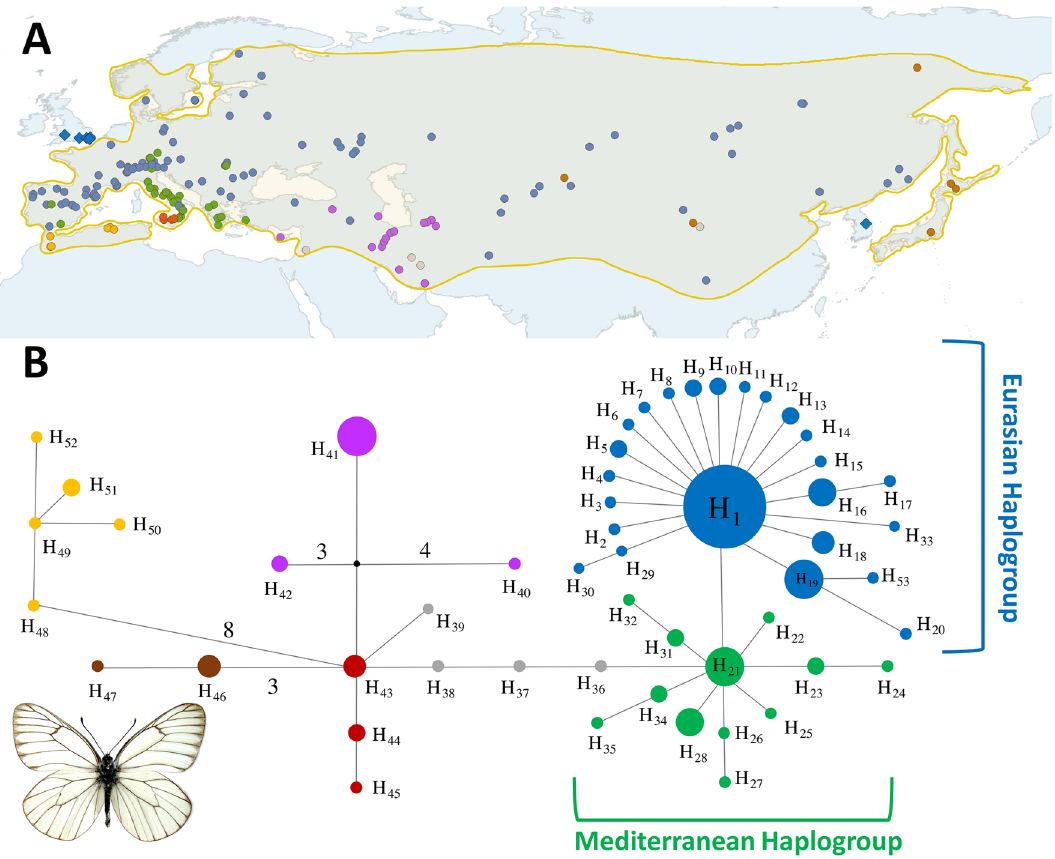
Figure 2. ( A ) Sampling localities and approximate geographic distribution areas of the Aporia crataegi redrawn after 9,23,25 . Sampling localities for the populations included in this study are showed with different coloured circles, while the extinct populations are indicated with squares. The map was prepared using Quantum GIS 2.8.2 (https ://qgis.org/downl oads/) based on a map from Natural Earth (www.natur alear thdat a.com). ( B ) Median-Joining Network of A. crataegi COI sequences. The size of circles is proportional to haplotype frequency and numbers of mutations between haplotypes are shown at the connections, except for single or double substitutions. In both figures main haplogroups are highlighted and shown in different colours. Aporia crataegi image is of a specimen from Uzbekistan (UZTAS: Supplementary Dataset File; image courtesy of Josef de